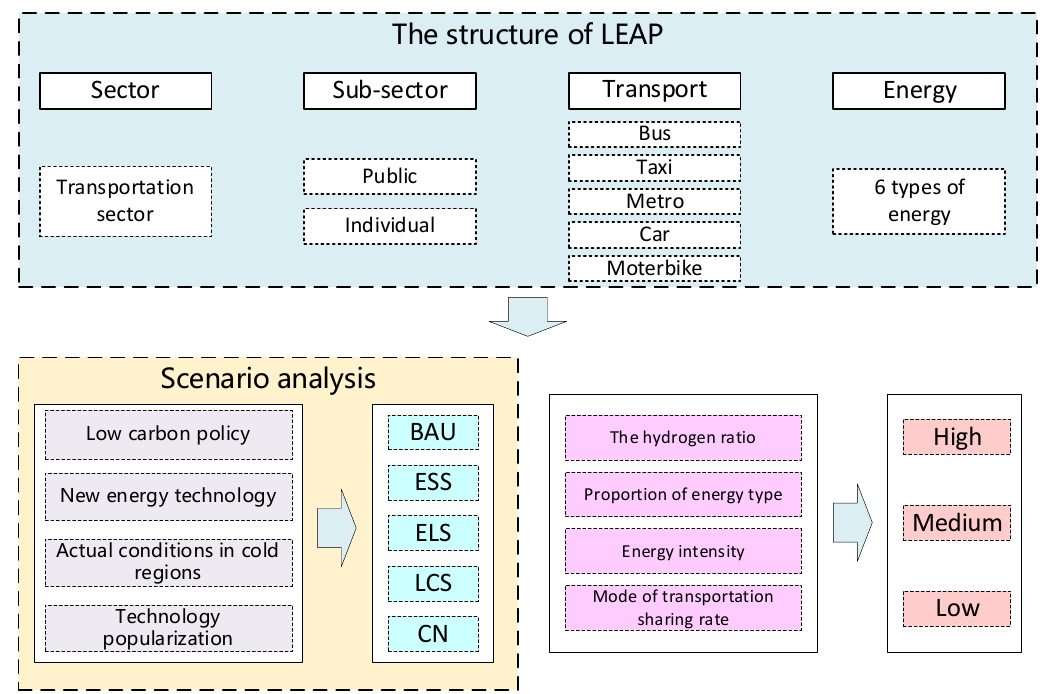
Figure 1. Research